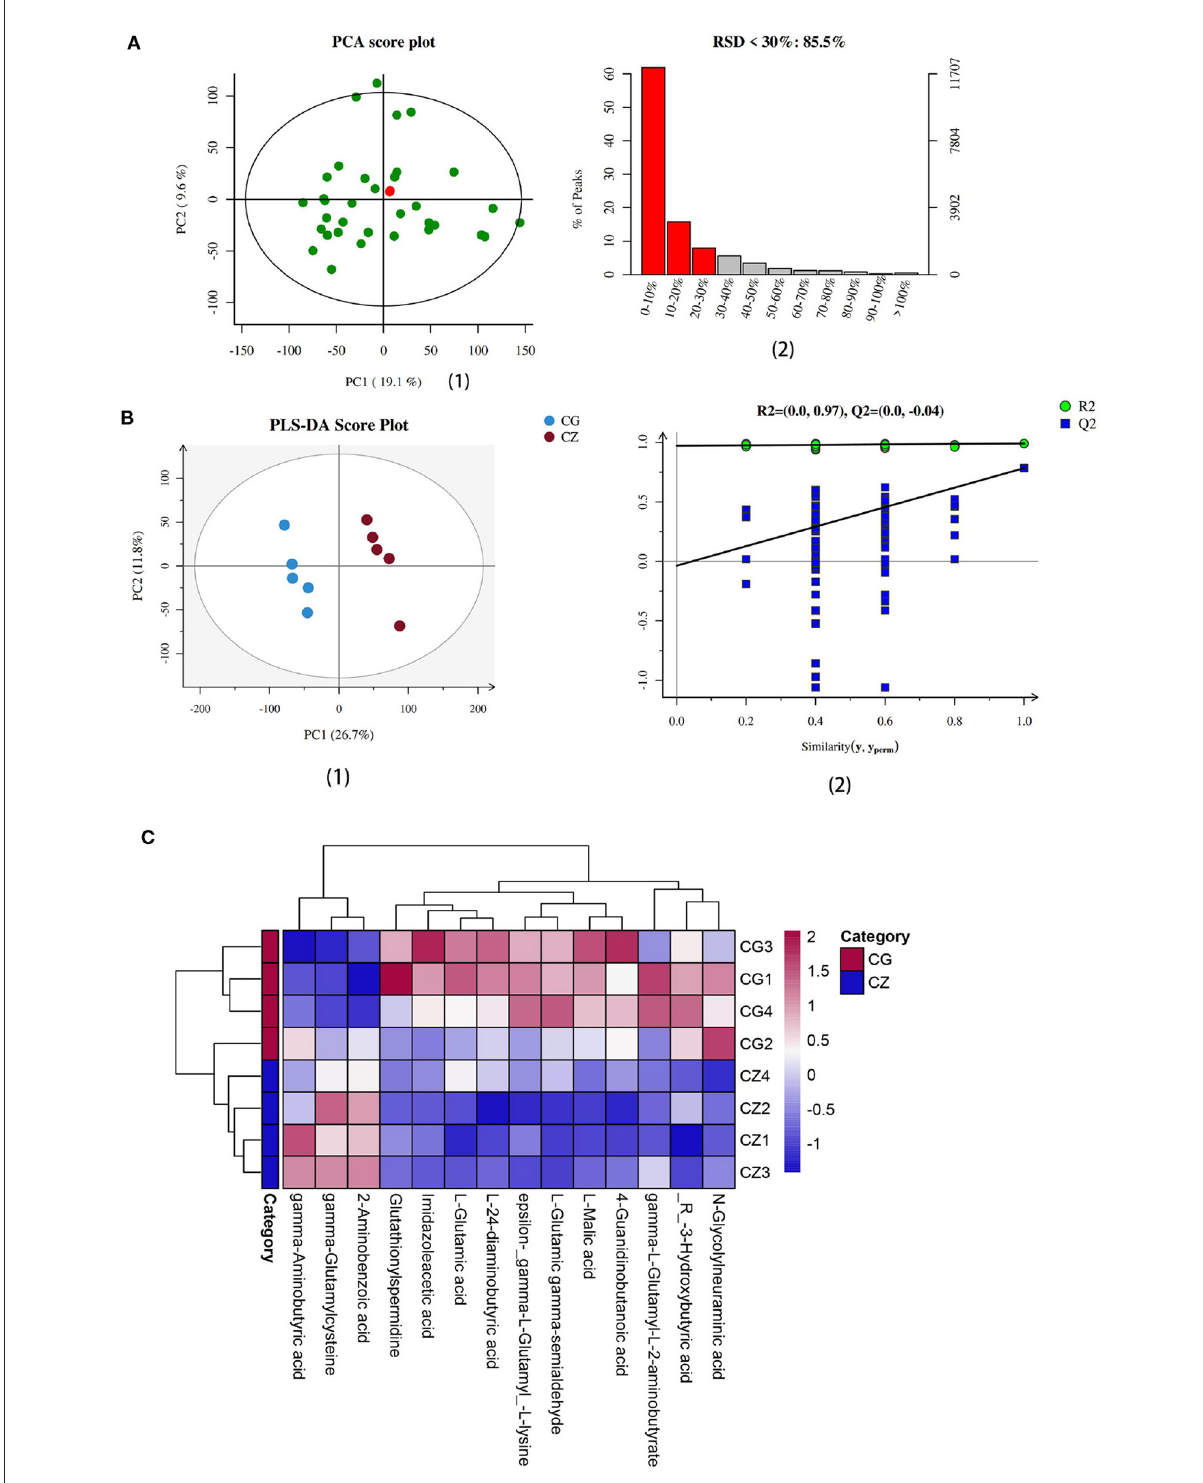
FIGURE3 Determination and heat map of intestinal metabolites we focus in hypertension of liver-Yang hyperactivity syndrome induced by a high salt diet. (A) Quality assurance results diagramof positive ions. (1) The middle green dots are samples (the figure is measured together with multiple groups of data, two of which are used in this paper), the red dots are QC samples. (2) The left ordinate is the proportion of RSD < 30%, the right ordinate is the specific value, and the abscissa is the range of RSD value. (B) (1) PLS-DA score plot of positive ions, (2) Permutation testing of positive ions . (C) The heat map of cluster analysis of differential metabolites. CZ, normal group, CG, hypertensive